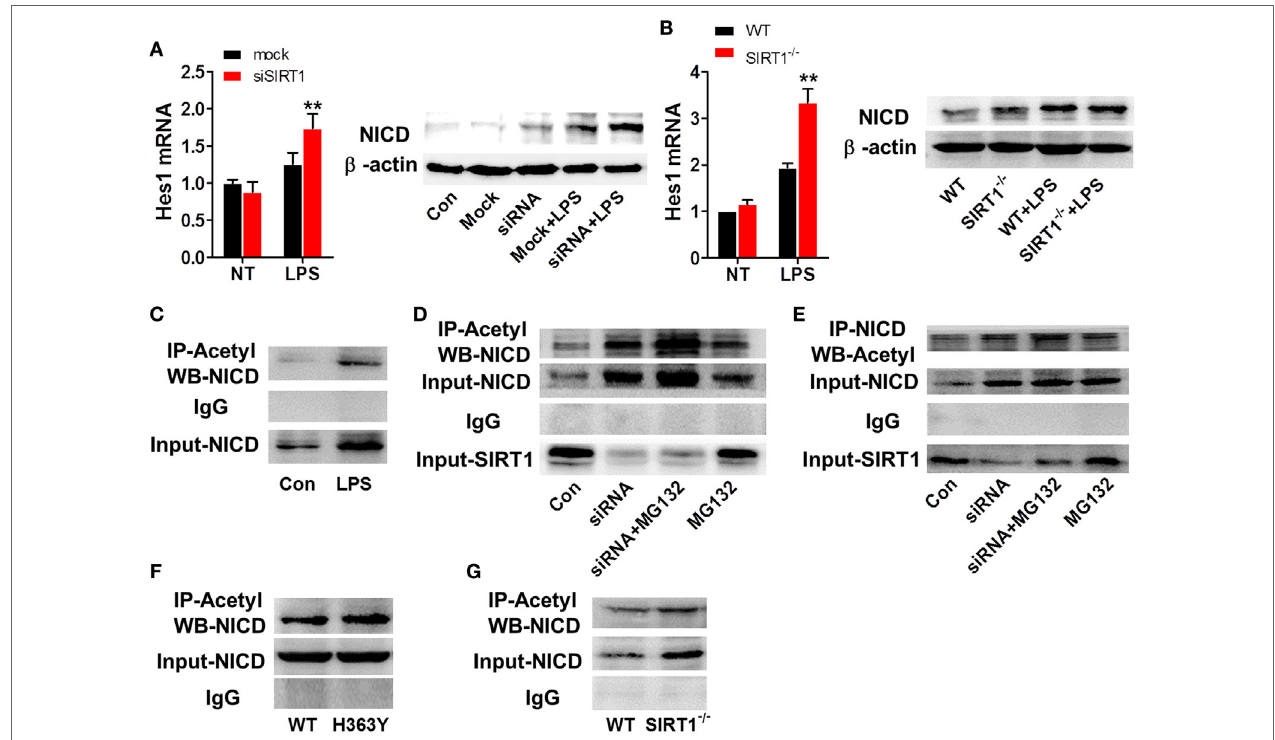
FigUre 6 | SIRT1 activation was negatively correlated with intracellular domain of Notch (NICD) levels. (a) RAW264.7 cells transfected with SIRT1 siRNA or mock siRNA were treated with lipopolysaccharide (LPS) or PBS, and then RT-PCR and Western blotting were used to assess Hes1 mRNA and NICD protein levels. (b) Wild-type (WT) and sirt1 − / − macrophages were treated with LPS or PBS and then Hes1 mRNA and NICD protein levels were examined using RT-PCR and Western blotting. (c) RAW264.7 cells were treated with LPS or PBS (control), and then the NICD acetylation level was evaluated by performing immunoprecipitation (IP) with anti-acetylation antibody and Western blotting with anti-NICD antibody. NICD expression in the whole-cell lysates was confirmed through Western blotting. (D) RAW264.7 cells were divided into control group (PBS), siSIRT1 group (SIRT1 siRNA + LPS), siSIRT1 + MG132 group (SIRT1 siRNA + LPS + MG132),